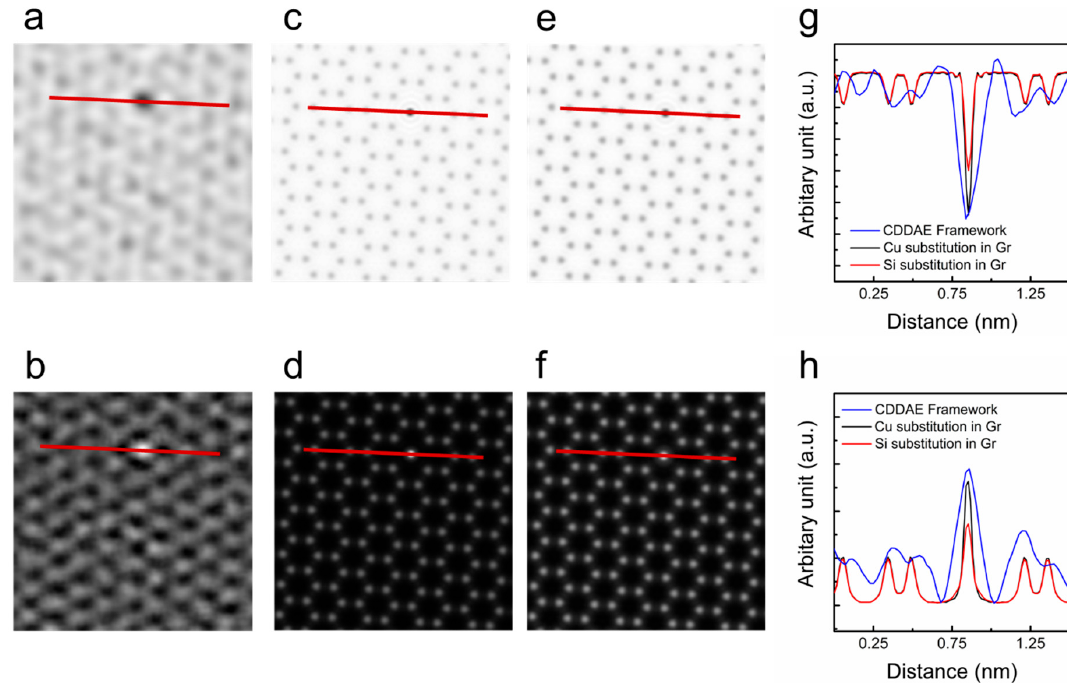
Figure 3. ( a ) Phase image and ( b ) amplitude image of the reconstructed exit wave, phase, and amplitude, from the atomic-resolution transmission electron microscopy (ARTEM) image by the CDDAE framework. Simulated ( c ) phase image and ( d ) amplitude image of the substituted Cu single atom in the graphene lattice. Simulated ( e ) phase image and ( f ) amplitude image of the substituted Si single atom in the graphene lattice. ( g , h ) The intensity profiles are plotted as solid red lines from left to right in each image.